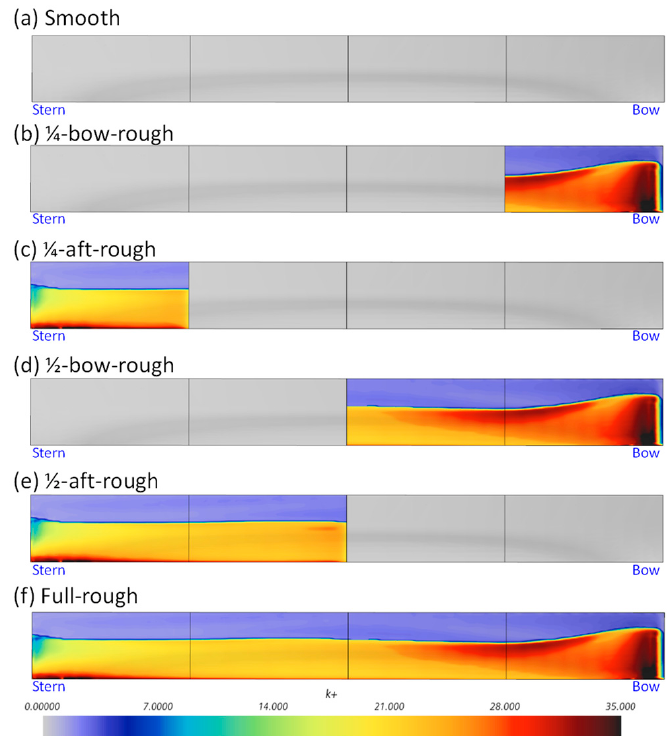
Figure 14. k + distribution on the Wigley hull with different hull conditions, Fr = Figure 14. 𝑘 (cid:2878) distribution on the Wigley hull with different hull conditions, 𝐹𝑟 = 0.3 Figure 15 shows the boundary layers represented by the axial velocity contours lim- /𝑉 ited to 𝑉 =0.9. When it comes to the homogeneous hull conditions, the results were (cid:3051) (cid:3046)(cid:3035)(cid:3036)(cid:3043) as expected. The full-rough case (Figure 15b) shows a thicker boundary layer compared to the smooth case (Figure 15a) and the difference becomes more apparent along with the flow, as similarly observed from previous studies, e.g., [17,18,25]. On the other hand, dif- ferences were observed with the heterogeneous hull conditions. As shown in Figures 15d and 14f, the boundary layer thicknesses around the forward part of the aft-rough condi- tions (where the surface is smooth) showed almost no differences compared to that of the smooth case (Figure 15a). In contrast, the bow-rough conditions (Figures 15c,e) showed increases in the boundary layer thickness not only around the forward parts (where the surface is rough) but also around the aft parts (where the surface is smooth), compared to the smooth case (Figure 15a). Interestingly, the bow-rough conditions showed thicker boundary layers on the aft parts compared to the aft-rough conditions. For example, the ½-bow-rough condition (Figure 15e) shows a thicker boundary layer than the ½-aft-rough condition (Figure 15f) even around the aft part.